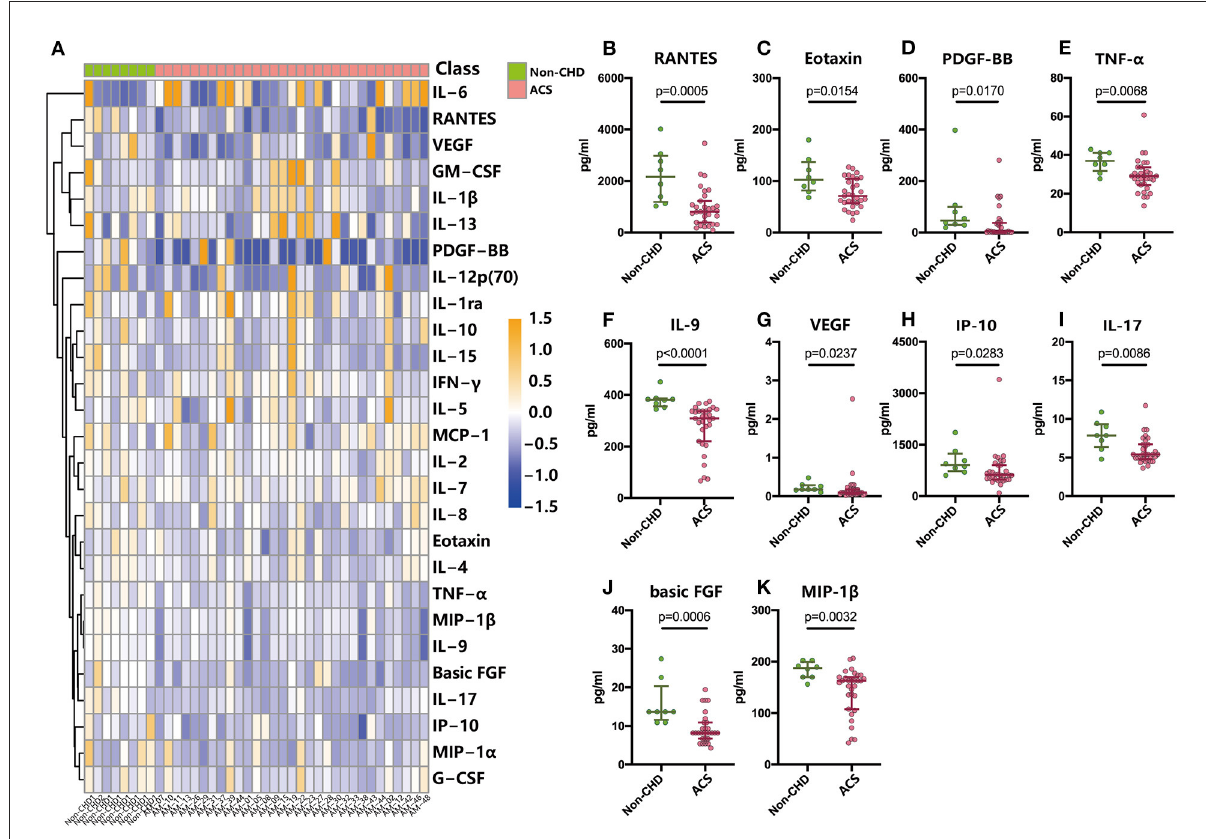
FIGURE2 Baseline plasma cytokine and chemokine levels in patients with non-CHD and ACS. Cytokine and chemokine levels were measured using Luminex assay in 8 patients without CHD and 31 patients with ACS. (A) Heat map of log2 fold changes in 27 analytes at baseline (corrected by the average levels in patients without CHD). (B–K) Differentially expressed analytes at baseline in patients with ACS compared with patients without CHD. Data are presented as medians with interquartile ranges. Differences were tested using Mann–Whitney U